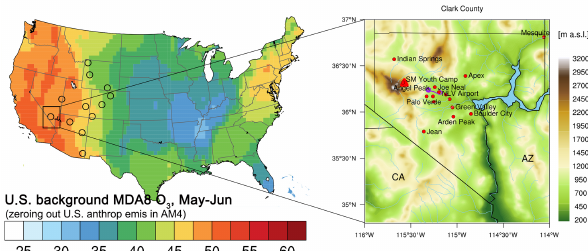
Figure 1. (Left) Mean US background MDA8 O 3 (ppbv) during FAST -LVOS (May–June 2017) estimated by zeroing out US anthro- pogenic emissions in the global high-resolution ( ∼ 50km × 50km) version of the GFDL-AM4 model (circles denote 12 selected high-elevation CASTNet sites); (Right) Topographic map of Clark County displaying the locations of Angel Peak (filled triangle) and regulatory O 3 monitoring sites (filled circles). The purple trace de- notes the Scientific Aviation flight track during 19:15–19:35UTC of 28 June 2017. The topographic data are from NOAA’s National Centers for Environmental Information (http://www.ngdc.noaa.gov/ mgg/global, last access: 10 October